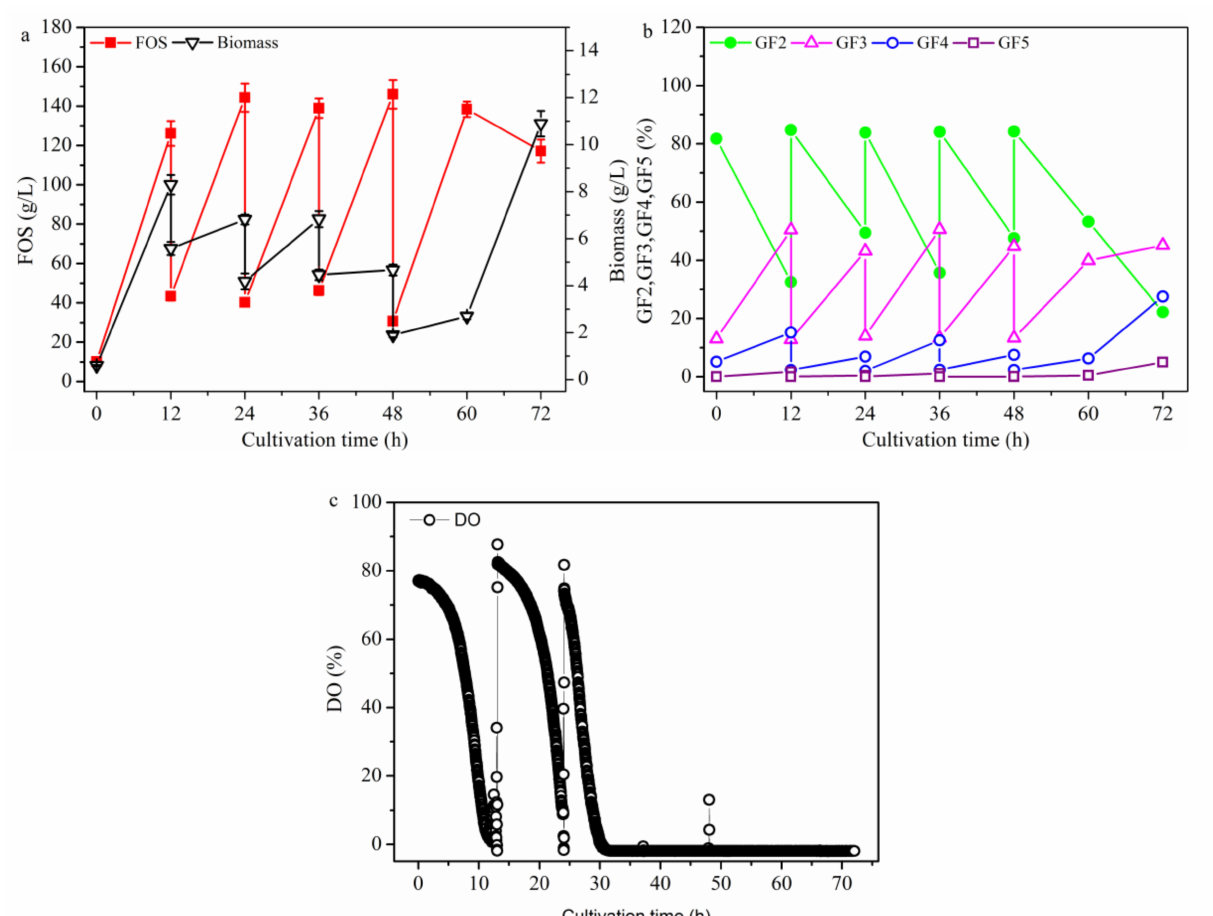
Figure 9. FOS production in a repeated-culture with 1.6 L broth discharged each time. After initial batch fermentation culture for 12 h, about 1.6 L of the broth was removed, and 1.6 L of the fresh medium was fed into the bioreactor. Fermentation was restarted under the same conditions as the batch fermentation in five cycles. The time courses refer to ( a ) FOS and biomass, ( b ) GF2, GF3,GF4 and GF5, and ( c ) DO. The working volume was 1.8 L. Data are given as the mean ± SD, n =